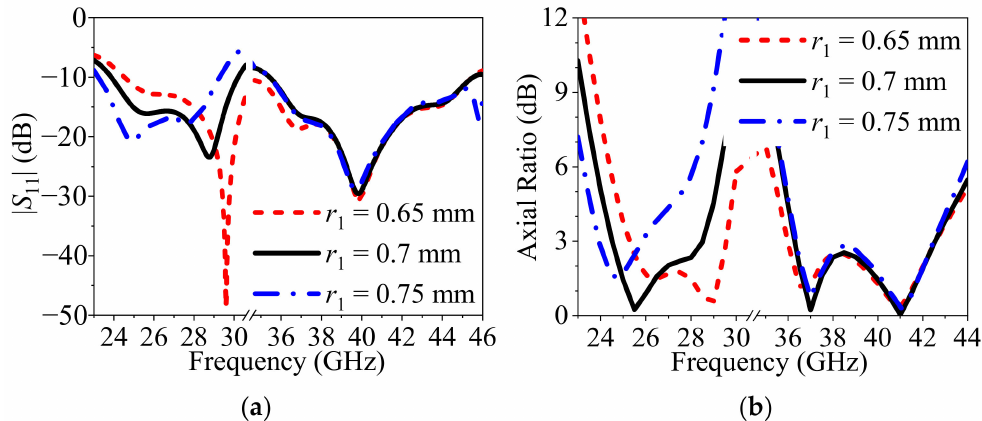
Figure 6. Simulated results of the dual-band CP DRA at different radius r 1 of Slot 1: ( a ) Reflection coefficients; ( b ) ARs.